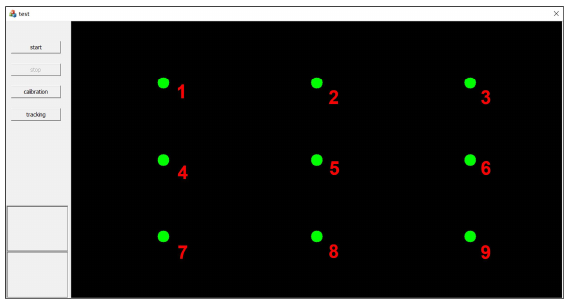
Figure 8. Numbered calibration points. The nine calibration points are sequentially numbered as 1 to 9.